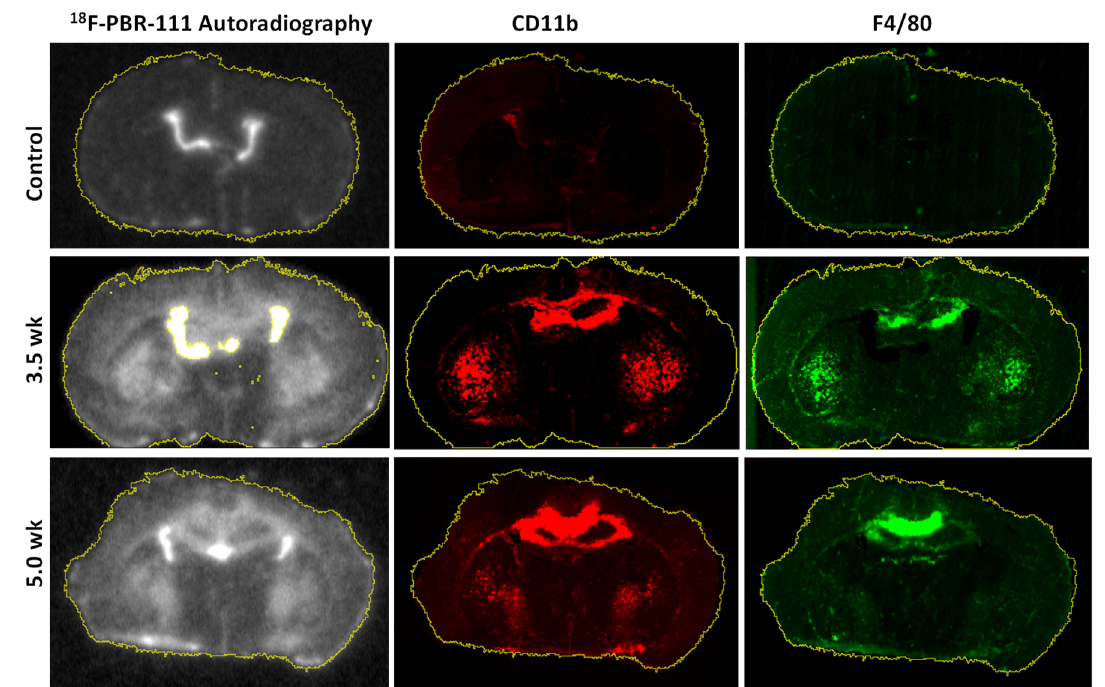
Figure 8. Spatial correlation of registered autoradiography (AR) and immunofluorescence (IF) images of whole brain sections. Background regions and ventricle regions were excluded. In this image, the corpus callosum demonstrates slightly more uptake from 3.5 to 5.0 weeks, while in the caudate and putamen region (S), uptake decreases. The internal capsule and putamen area, however, is increased more at 3.5 weeks, showing that there are more microglia at this location at 3.5 weeks than at 5.0 weeks. Slight differences in C11b and F4/80 may reveal unexplained MM population differences.